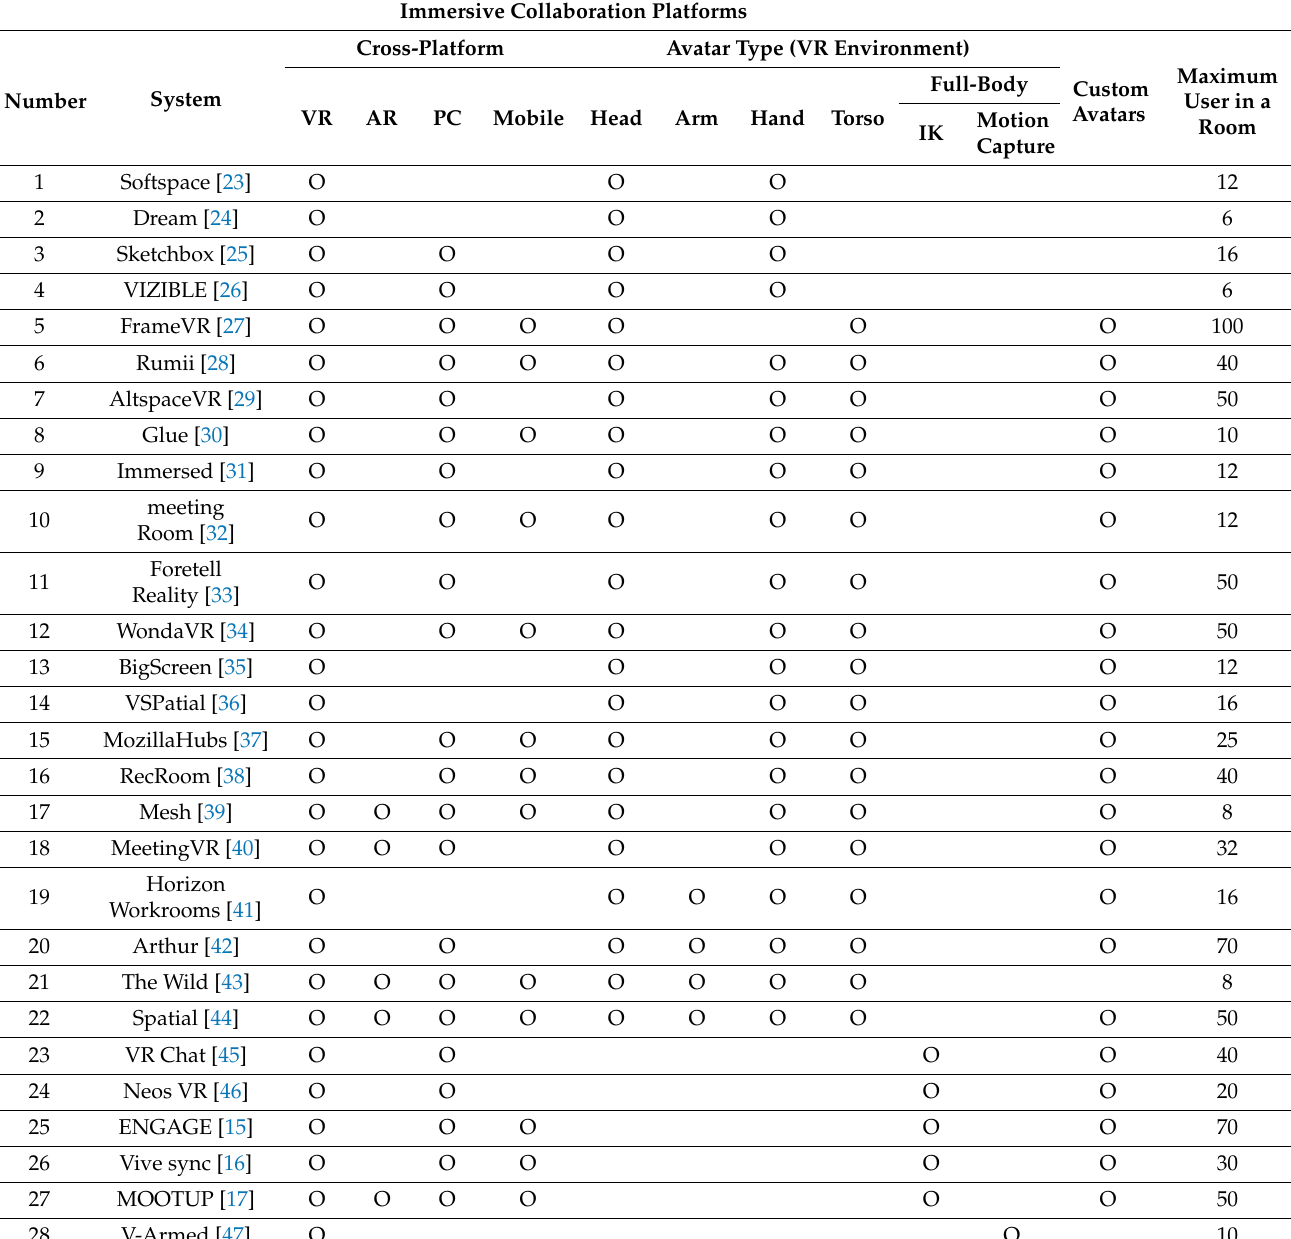
Table 1. Immersive collaboration platform